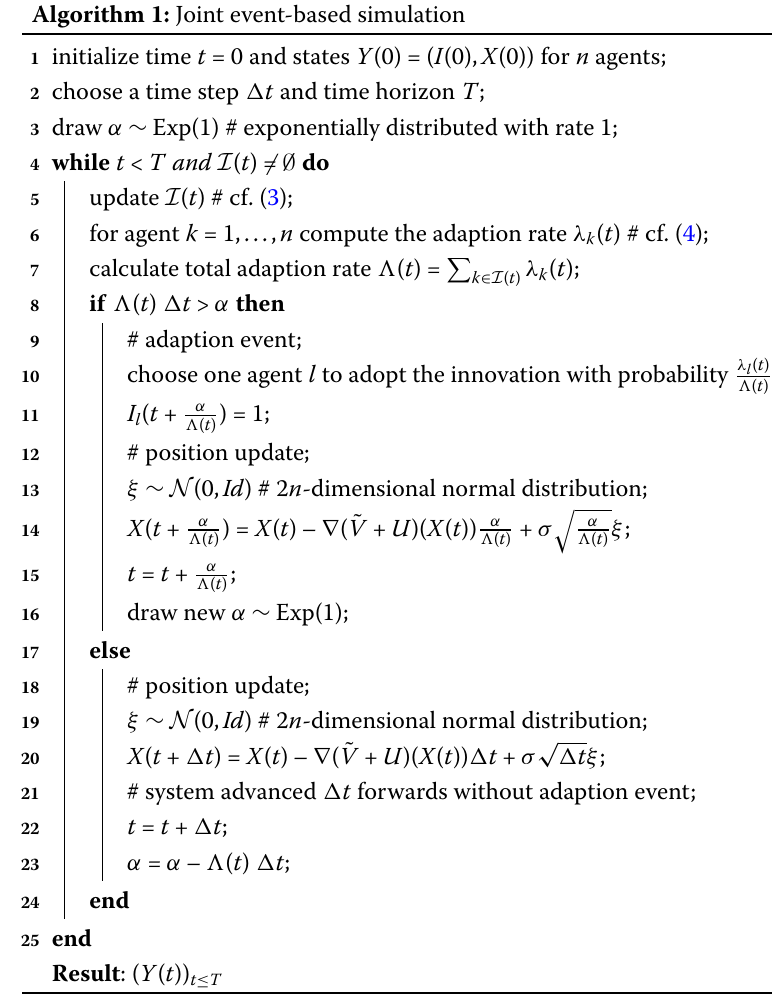
Algorithm 1: Joint event-based